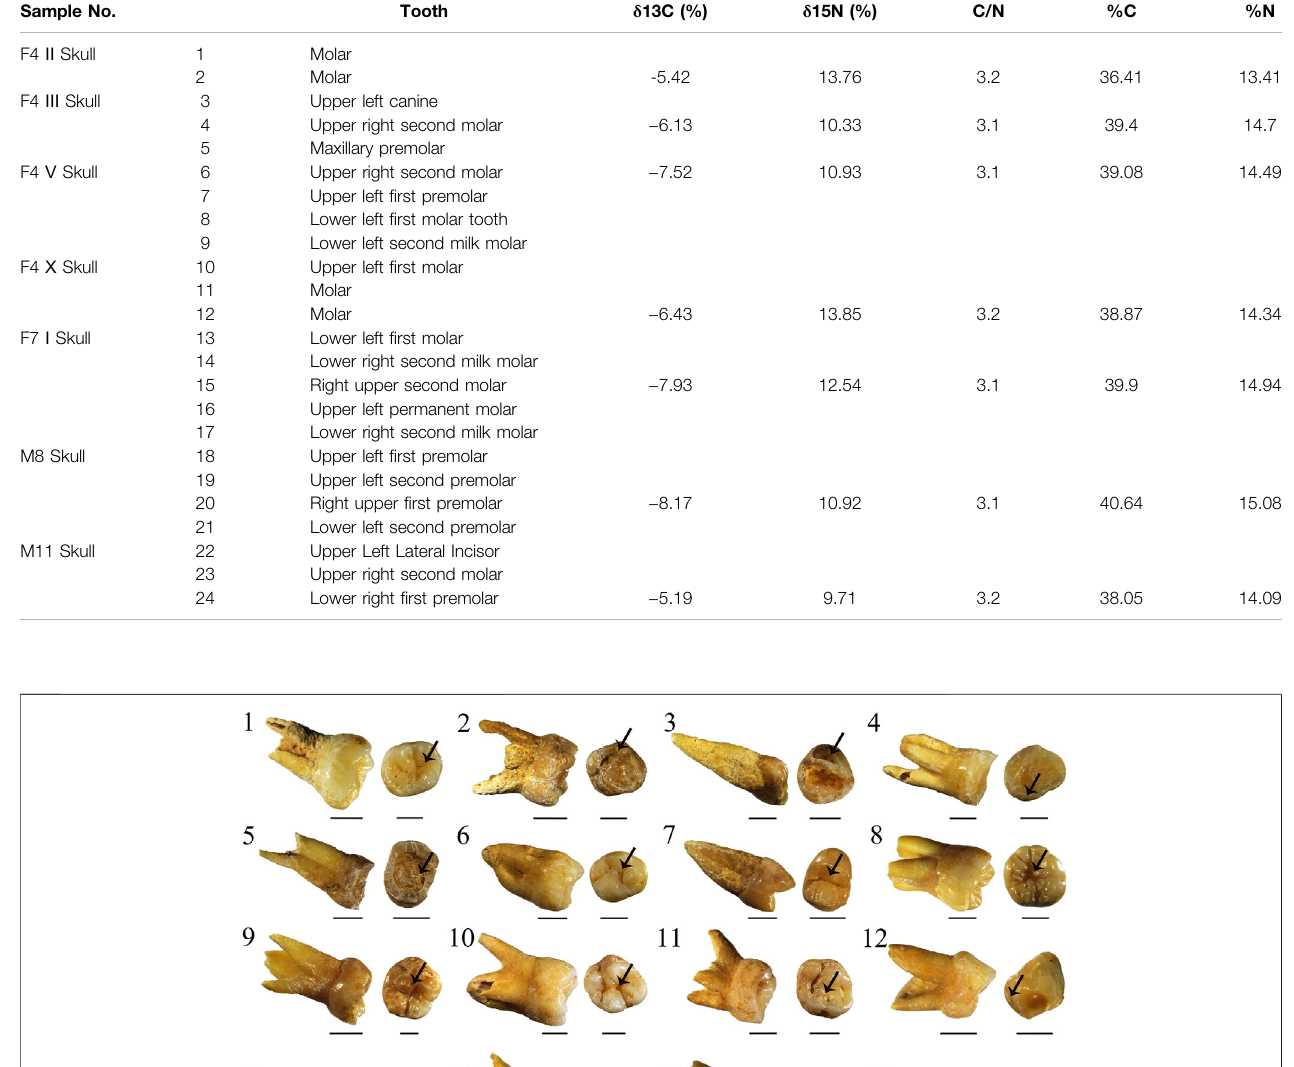
TABLE 1 | Information on human tooth samples at the Lajia site and results of carbon and nitrogen isotopic testing. Sample No.